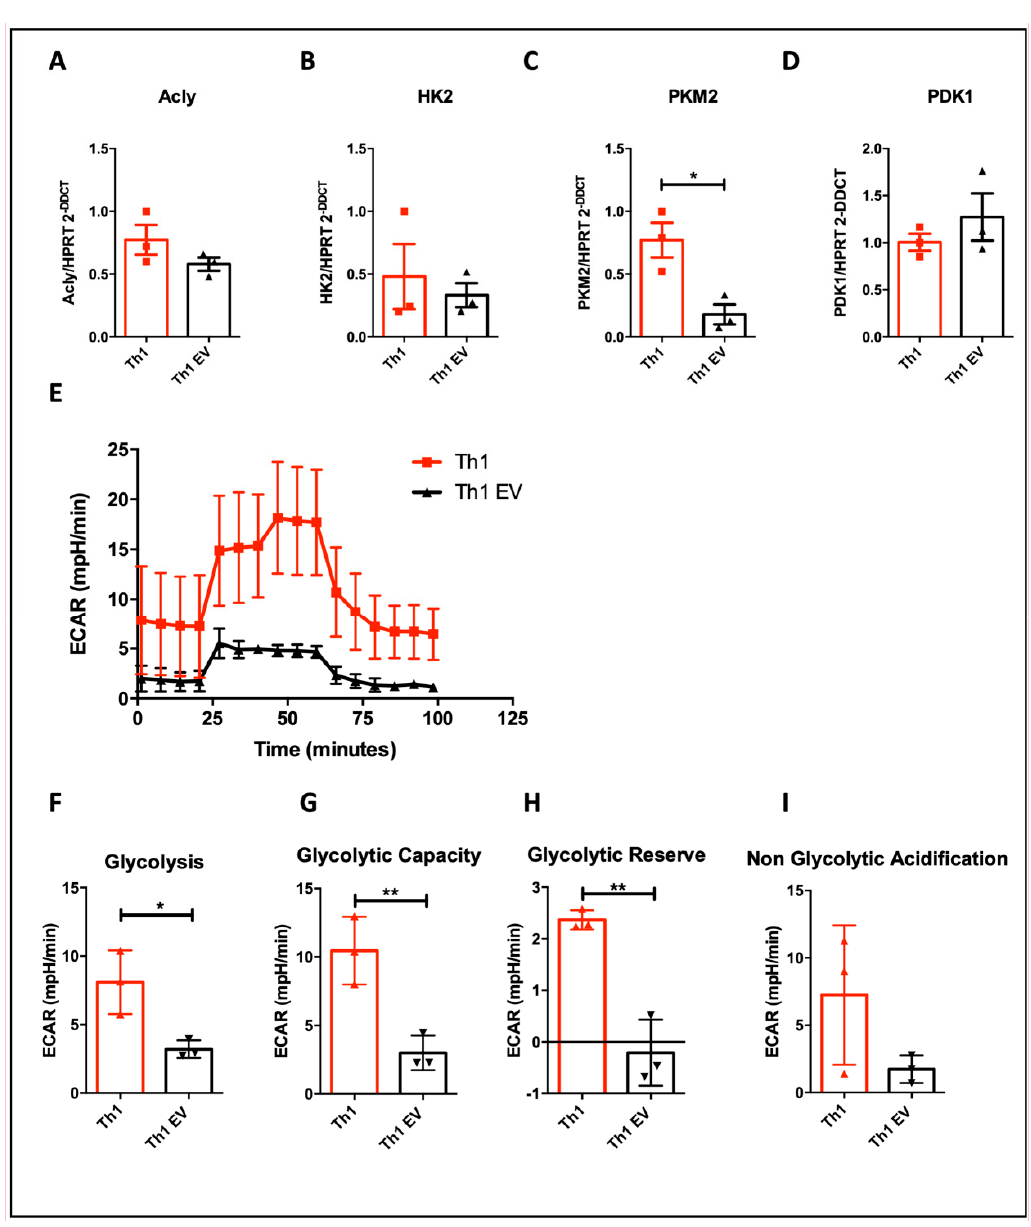
Figure 8. Effects of MSC-EVs on T cell glycolytic metabolism: Th1-differentiated cells were evaluated by the expression of metabolic-related genes, such as ACLY ( A ), HK2, ( B ), PKM2 ( C ) and PDK1 ( D ) by RT-PCR. A Seahorse analysis was performed in order to evaluate glycolytic metabolism ( E ). Separately, glycolysis ( F ), glycolytic capacity ( G ) glycolytic reserve ( H ) and non-glycolytic acidification ( I ) rates were obtained. n = 3 (* p < 0.05).